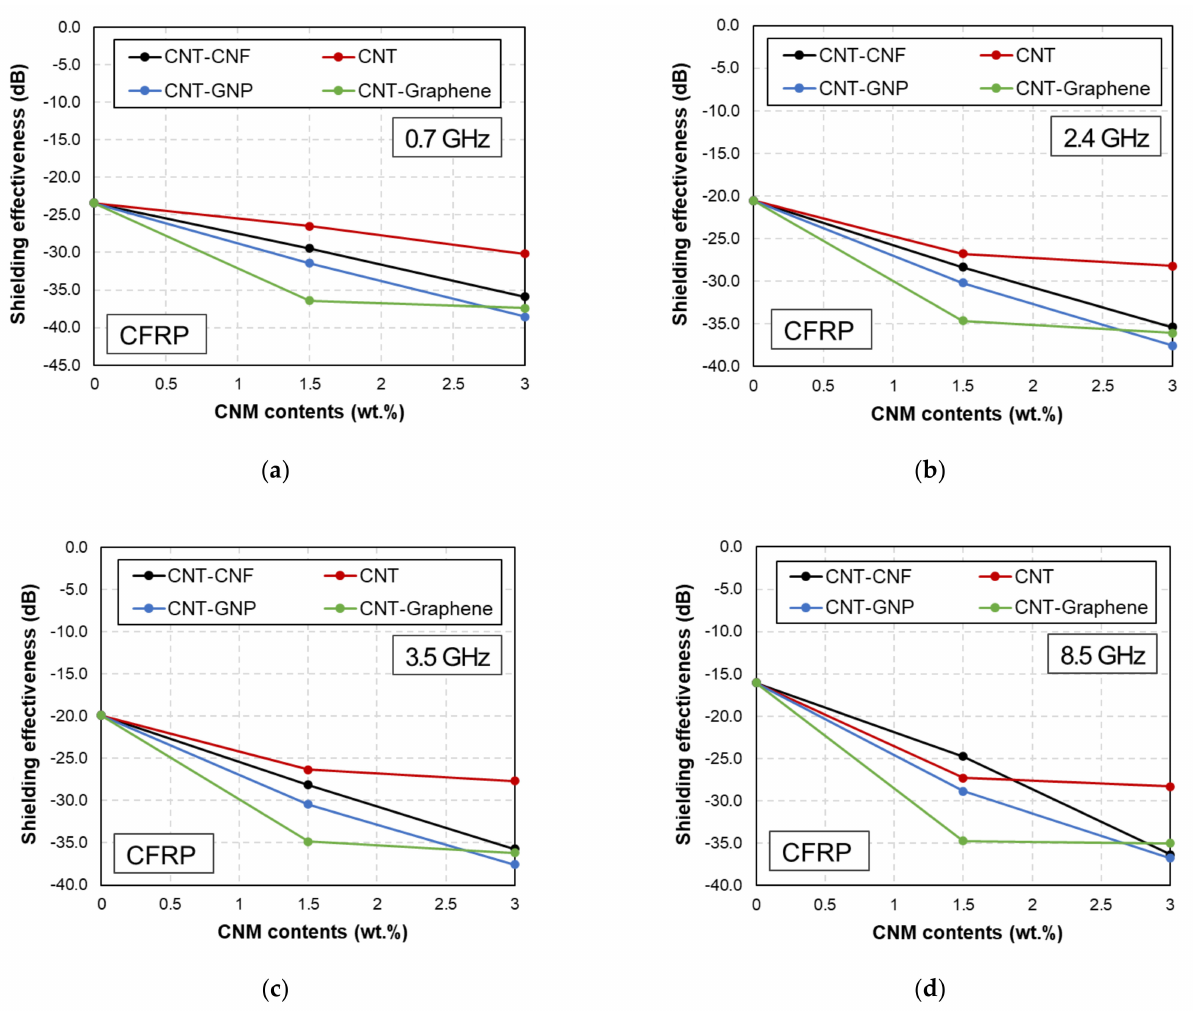
Figure 4. EMI shielding effectiveness of CFRP-based samples with different amounts of CNMs at ( a ) 0.7, ( b ) 2.4, ( c ) 3.5, and ( d ) 8.5